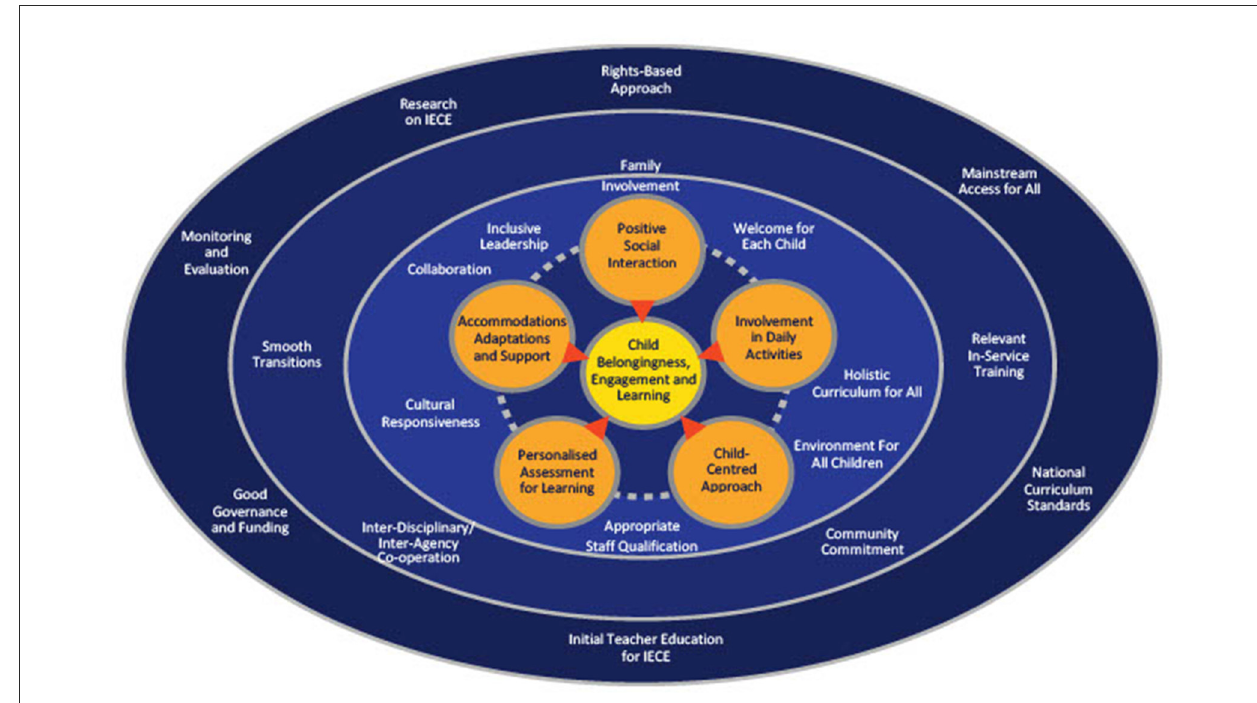
FIGURE1 The ecosystem model of inclusive early childhood education (cited from EASNIE, 2017a, p. 37).